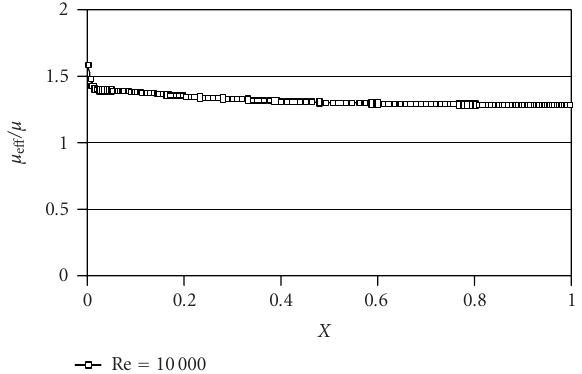
Figure 6: E ff ective viscosity ratio along the channel wall for ˙ m r = 1 / 1 and Re = 10000.